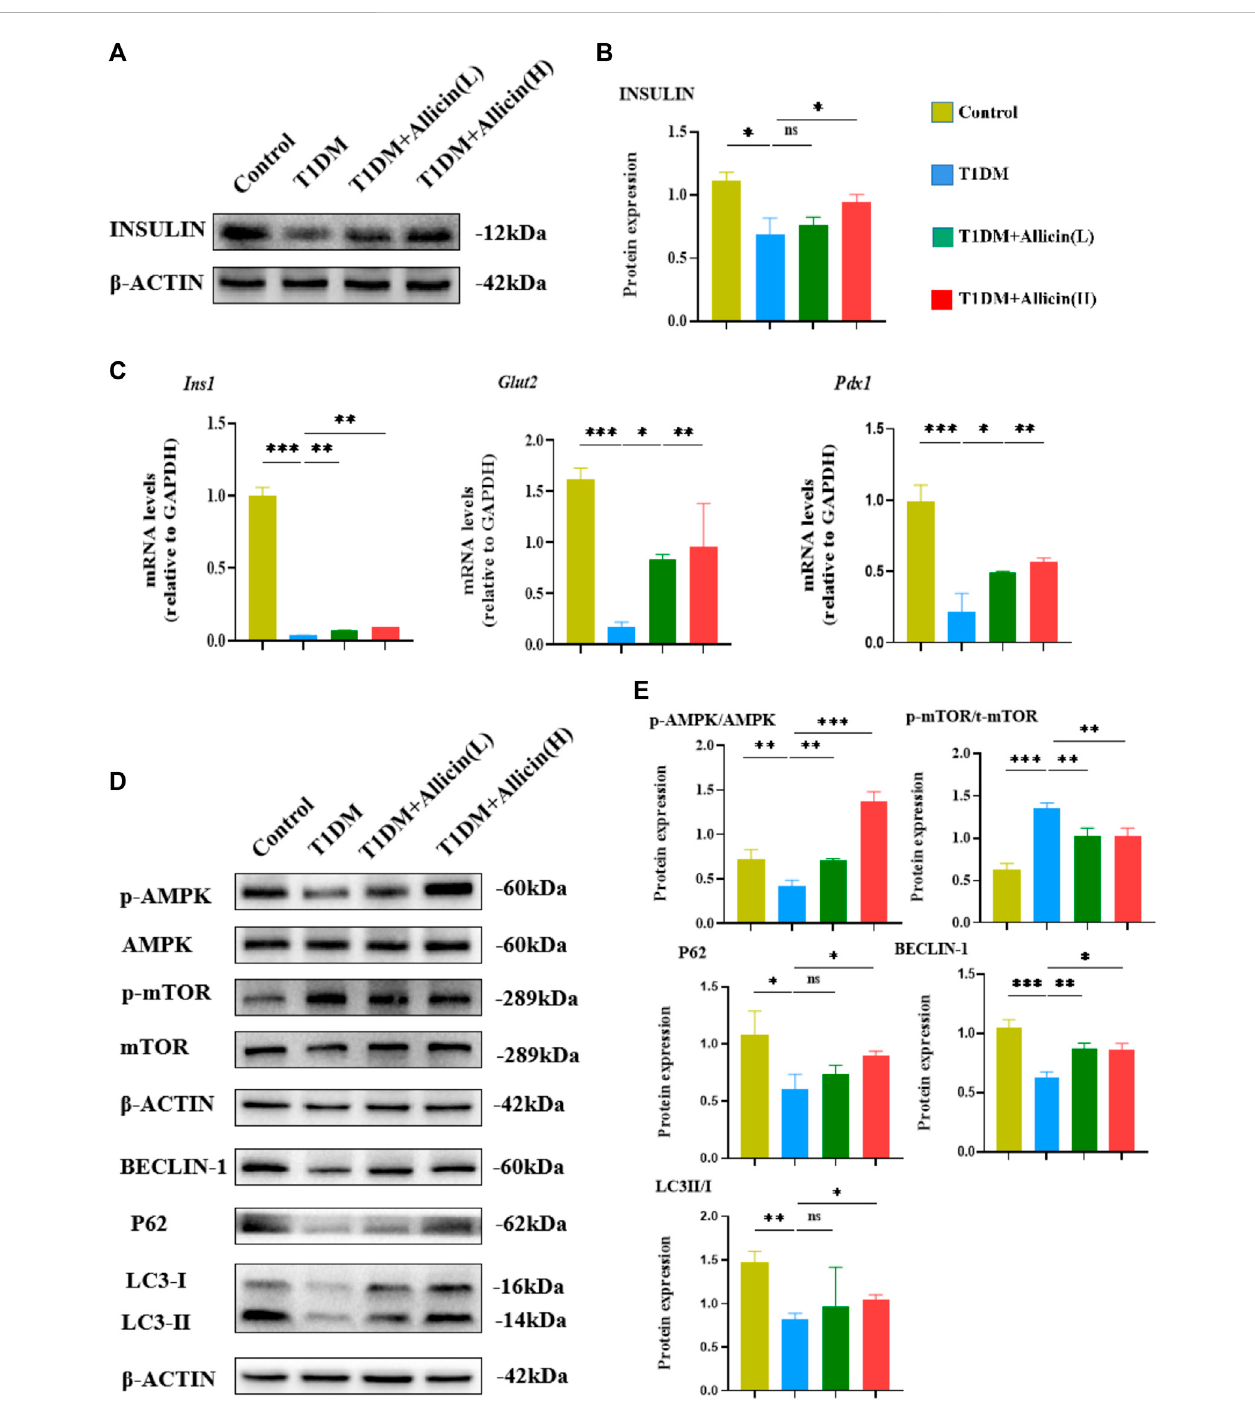
FIGURE 3 Allicin mediated pancreatic β cell autophagy through activating AMPK/mTOR pathway in T1DM mice. (A) Western blot gel images of INSULIN and β - ACTINineachgroup. (B) Thebargraphrepresentsthequanti fi cationofgelbands. (C) ThemRNAlevelsof Ins1 , Glut2 ,and Pdx1 ineachgroupbyRT-qPCR( n = 3). (D) The western blot gel images of proteins in AMPK/mTOR-mediated autophagy fl ux pathway in each group. (E) The bar graphs represent the quanti fi cation of gel bands ( n = 3). Mean ± SD. *p < .05, **p < .01, ***p < .001 indicate signi fi cant differences, and ns > .05 shows no